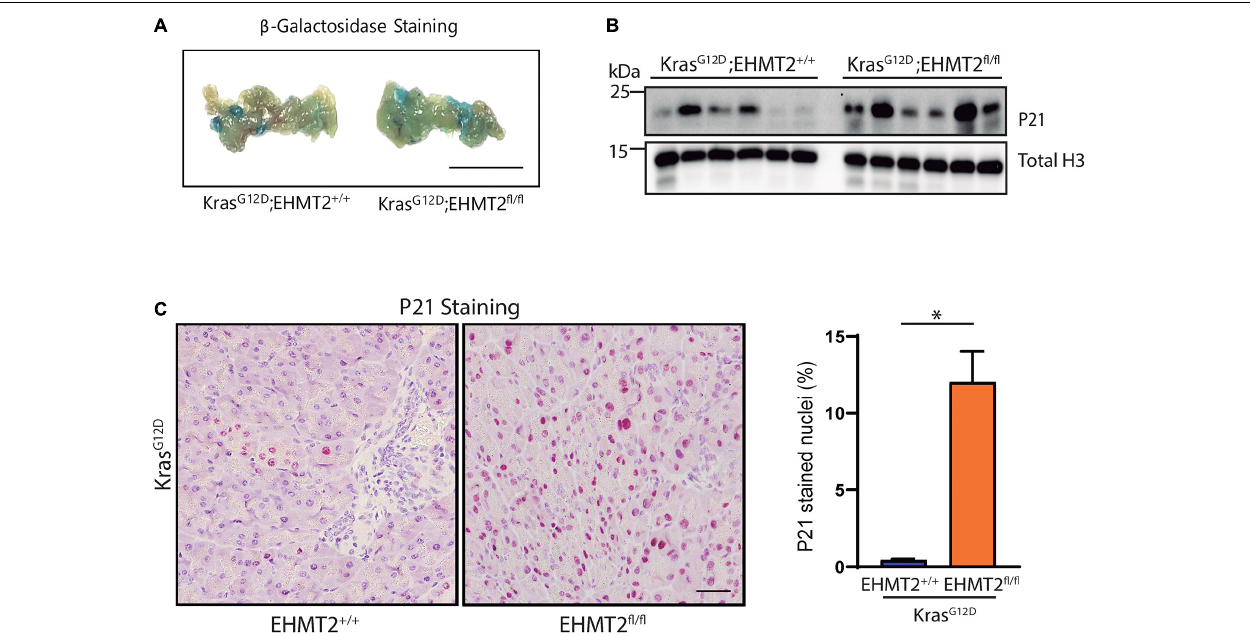
FIGURE 6 | EHMT2 inactivation induces cell senescence in the Kras G 12 D -expressing mouse pancreas coincident with increased P21. (A) Senescence-associated β -galactosidase staining on fresh pancreas tissue extracted from Pdx1-Cre;LSL-Kras G 12 D ;EHMT2 + / + and Pdx1-Cre;LSL-Kras G 12 D ;EHMT2 fl / fl animals. The presence of blue staining indicates senescence. Scale = 1 mm. (B) Western blot evaluation of P21 protein levels in whole pancreas lysates from Pdx1-Cre;LSL-Kras G 12 D ;EHMT2 + / + and Pdx1-Cre;LSL-Kras G 12 D ;EHMT2 fl / fl mice. Total H3 was used as loading control ( n = 6/group). Quantification is represented in Supplementary Figure 6B . (C) Left: Representative images from IHC staining for P21 on Pdx1-Cre;LSL-Kras G 12 D ;EHMT2 + / + and Pdx1-Cre;LSL-Kras G 12 D ;EHMT2 fl / fl pancreas tissue. Scale = 50 µ M. Right: Graph represents percentage of nuclei positive for P21 as quantified from a minimum of 5 random fields at 10 × magnification ( n = 3/group). ∗ indicates p -value ≤ 0.05; Student’s t -test with Welch’s correction. All data is expressed as mean ±